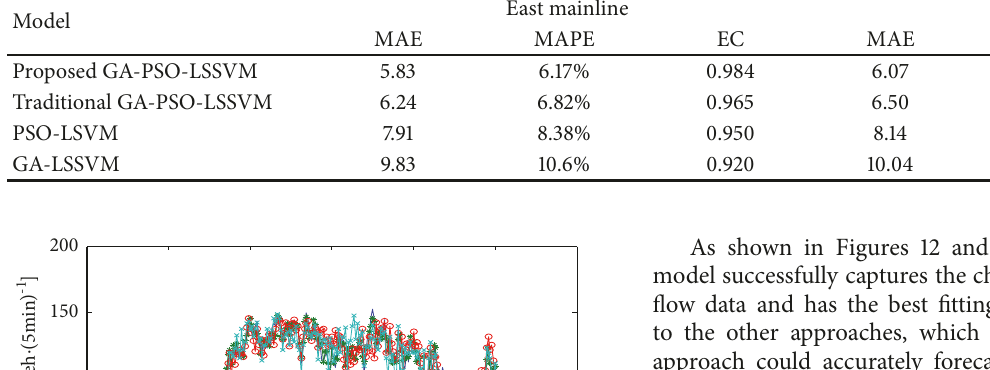
Actual data GA-PSO-LSSVM